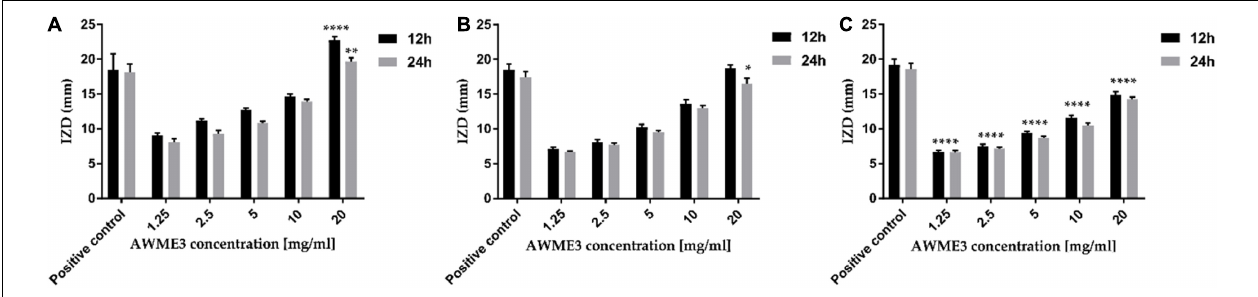
Frontiers in Microbiology |